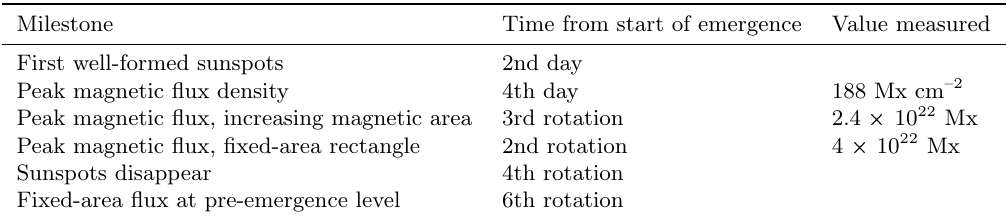
Table 4: Magnetic evolution milestones during the long-term evolution of sunspots in NOAA 7978 Milestone Time from start of emergence Value measured First well-formed sunspots 2nd day Peak magnetic flux density 4th day 188 Mx cm –2 Peak magnetic flux, increasing magnetic area 3rd rotation 2.4 (cid:214) 10 22 Mx Peak magnetic flux, fixed-area rectangle 2nd rotation 4 (cid:214) 10 22 Mx Sunspots disappear 4th rotation Fixed-area flux at pre-emergence level 6th rotation